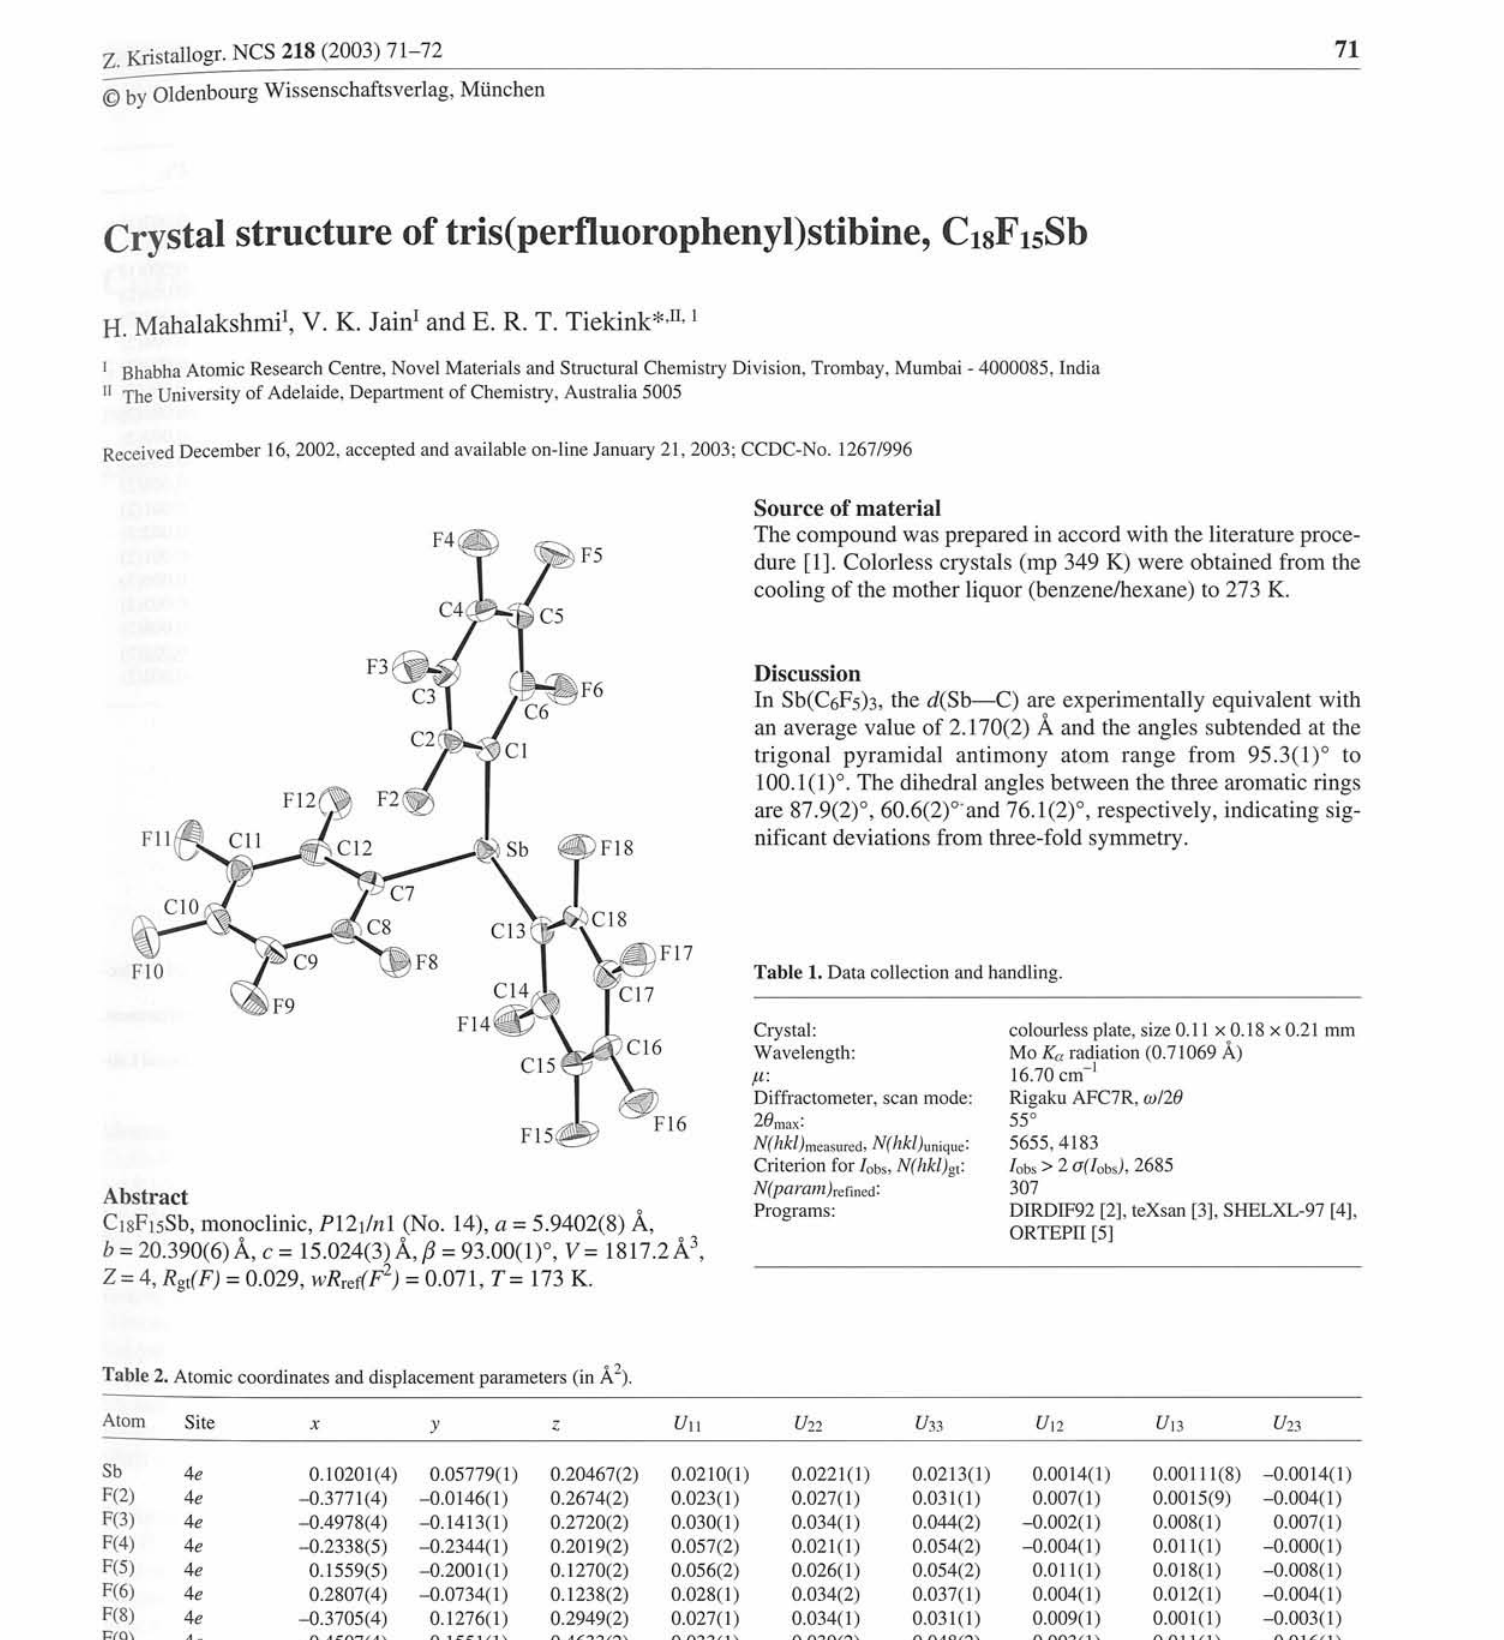
Table 2. Atomic coordinates and displacement parameters (in Â 2